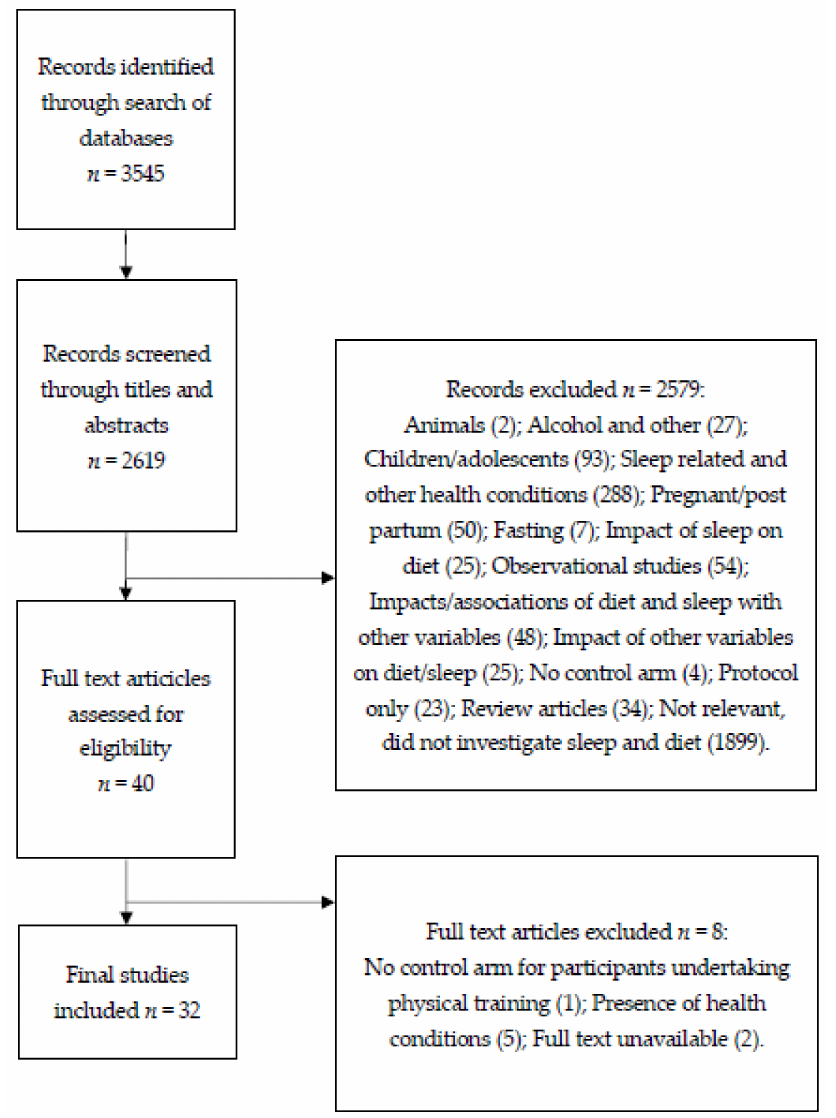
Figure 1. A diagram showing the selection process for